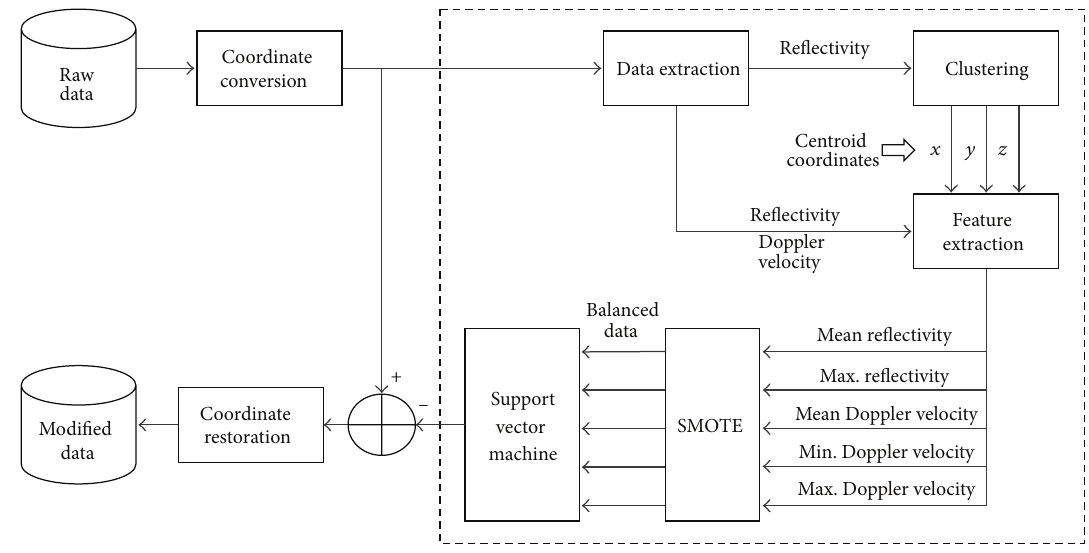
Figure 9: Overview of proposed SVM